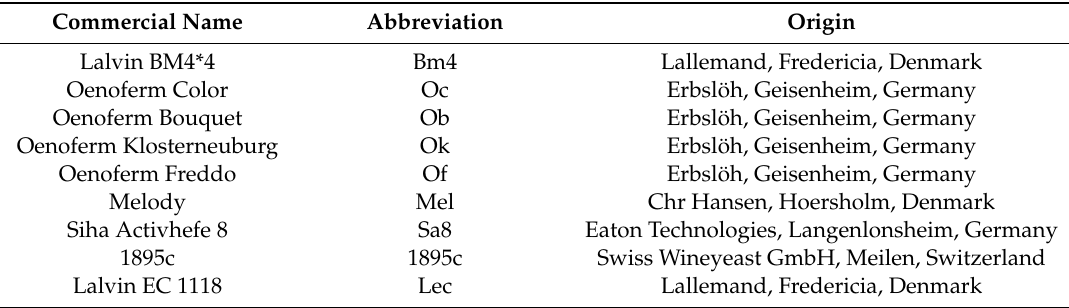
Table 1. Commercially available yeast